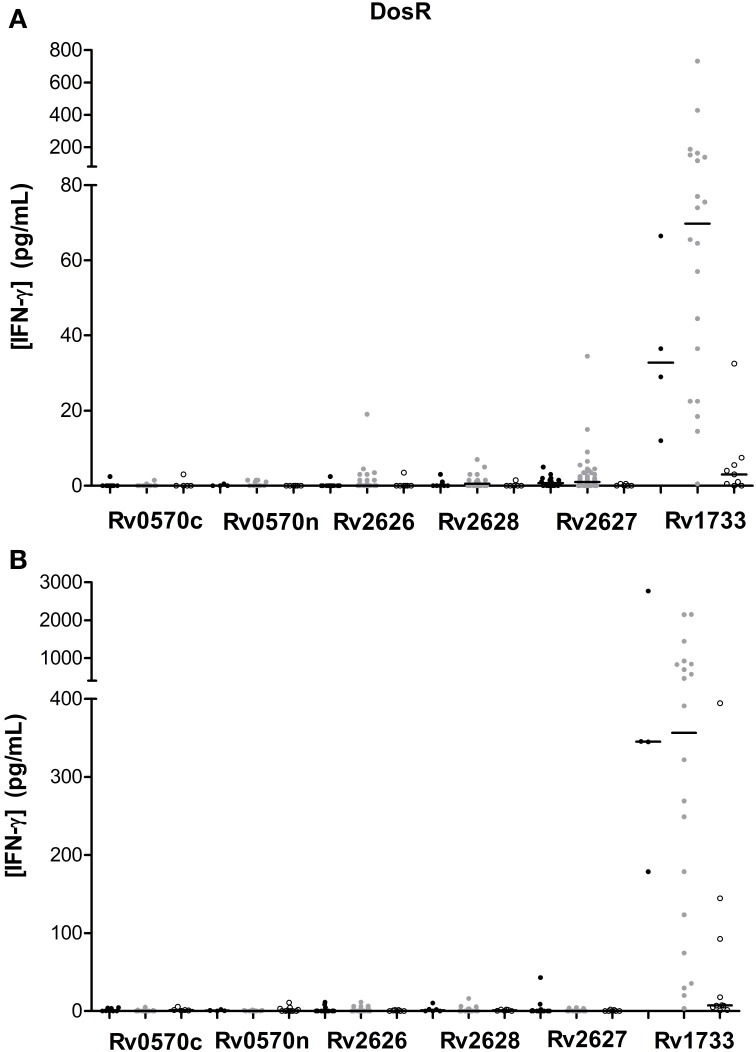
DosR regulon-encoded antigen stimulated IFN-γ response (pg/ml) after short (A) or long-term (B) incubation of whole blood from individuals without LTBI (black dots), with LTBI (gray dots), and active TB patients (empty dots). The horizontal line represents the median.